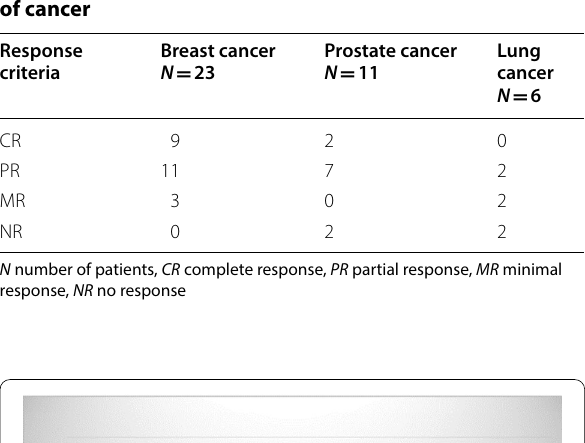
Table 5 Response assessment according to the type